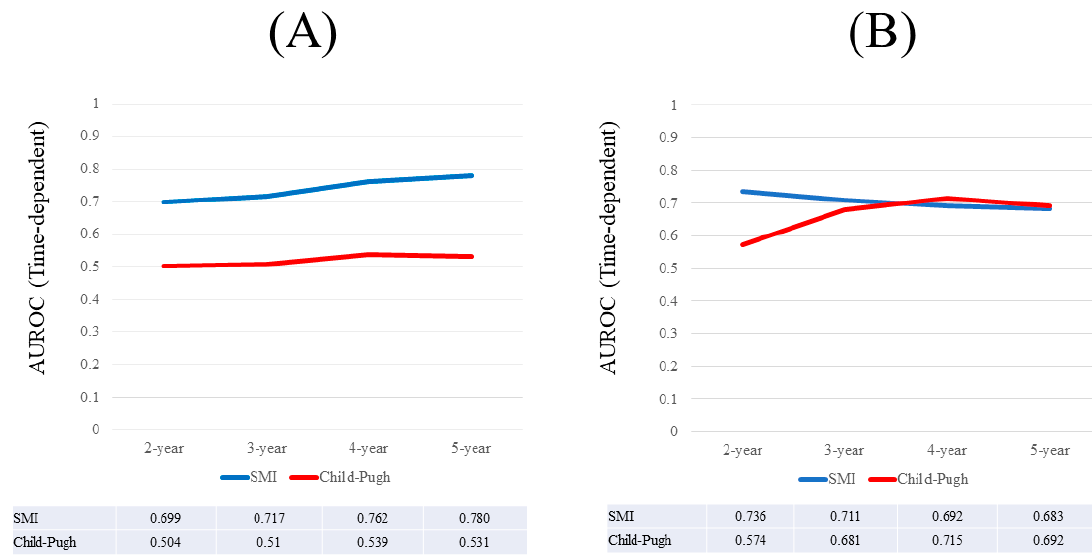
Figure 5. ( A ) Results for time-dependent ROC analyses at two-, three-, four-, and five-years of SMI and Child-Pugh scores for male Child-Pugh A patients; ( B ) Results for time-dependent ROC analyses at two-, three-, four-, and five-years of SMI and Child-Pugh scores for female Child-Pugh A patients. ROC; receiver operating characteristics, AUROC; area under the ROC, SMI; skeletal muscle mass index.